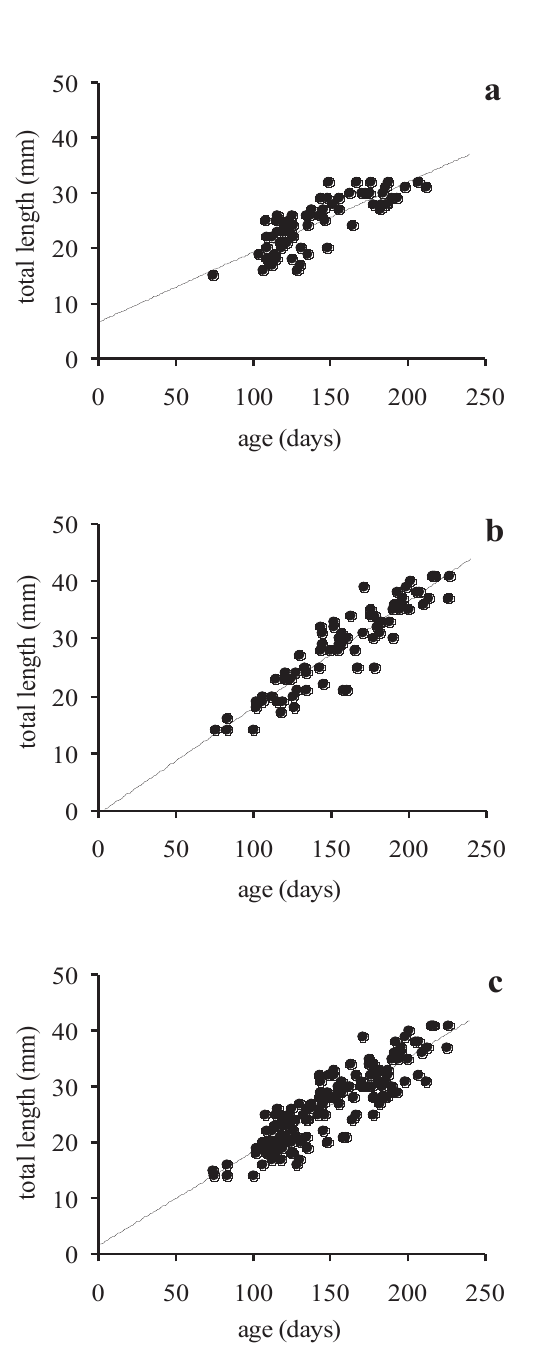
F IG . 3. – Simple linear regressions fitted to age-length data of females (a), males (b) and whole population (c) of C. linearis from the Adriatic